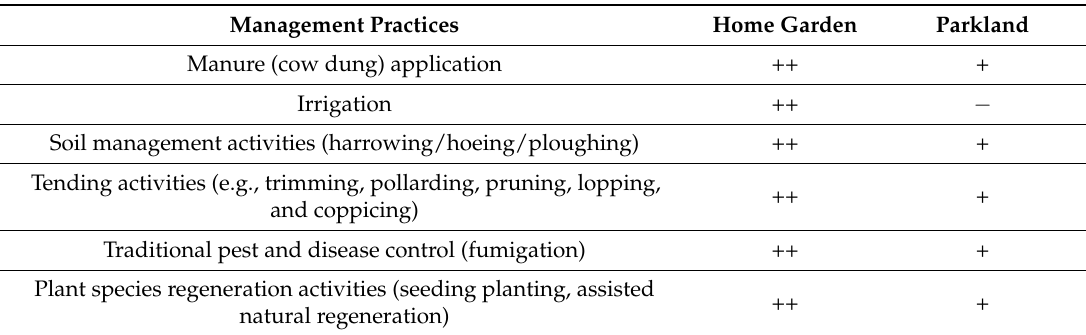
Table 7. Home-garden and parkland agroforestry management practices as reported by HHs in Assosa district, western